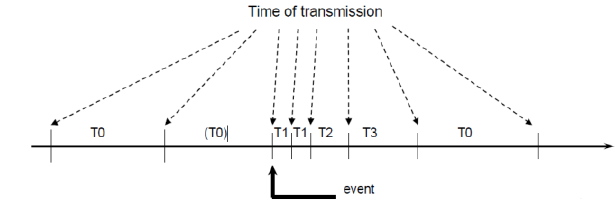
Fig. 8. Transmission time for